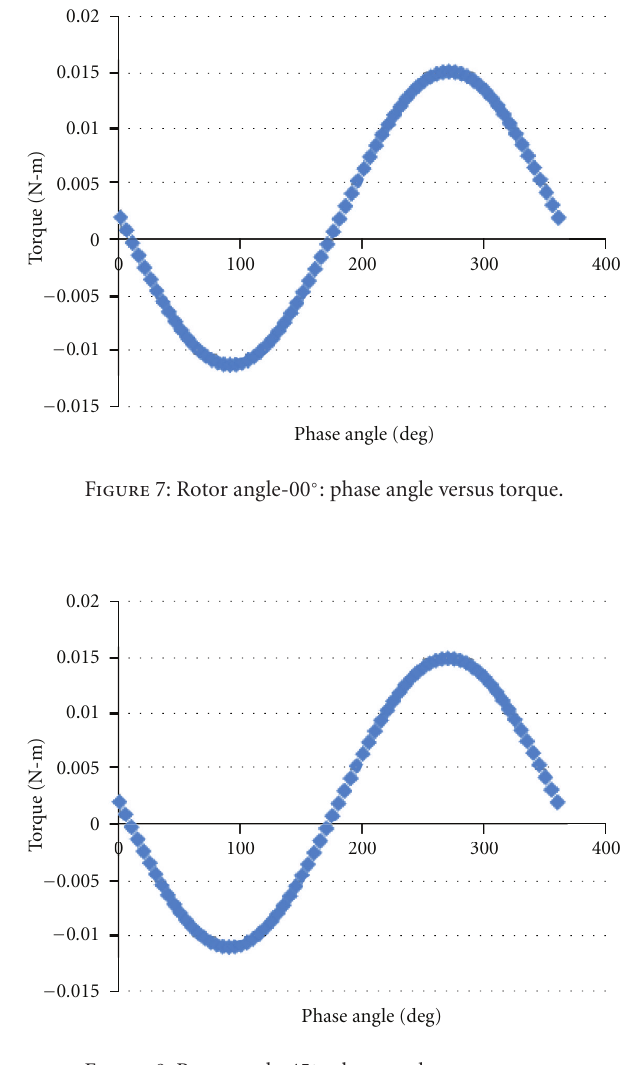
Figure 8: Rotor angle-45 ◦ : phase angle versus torque.